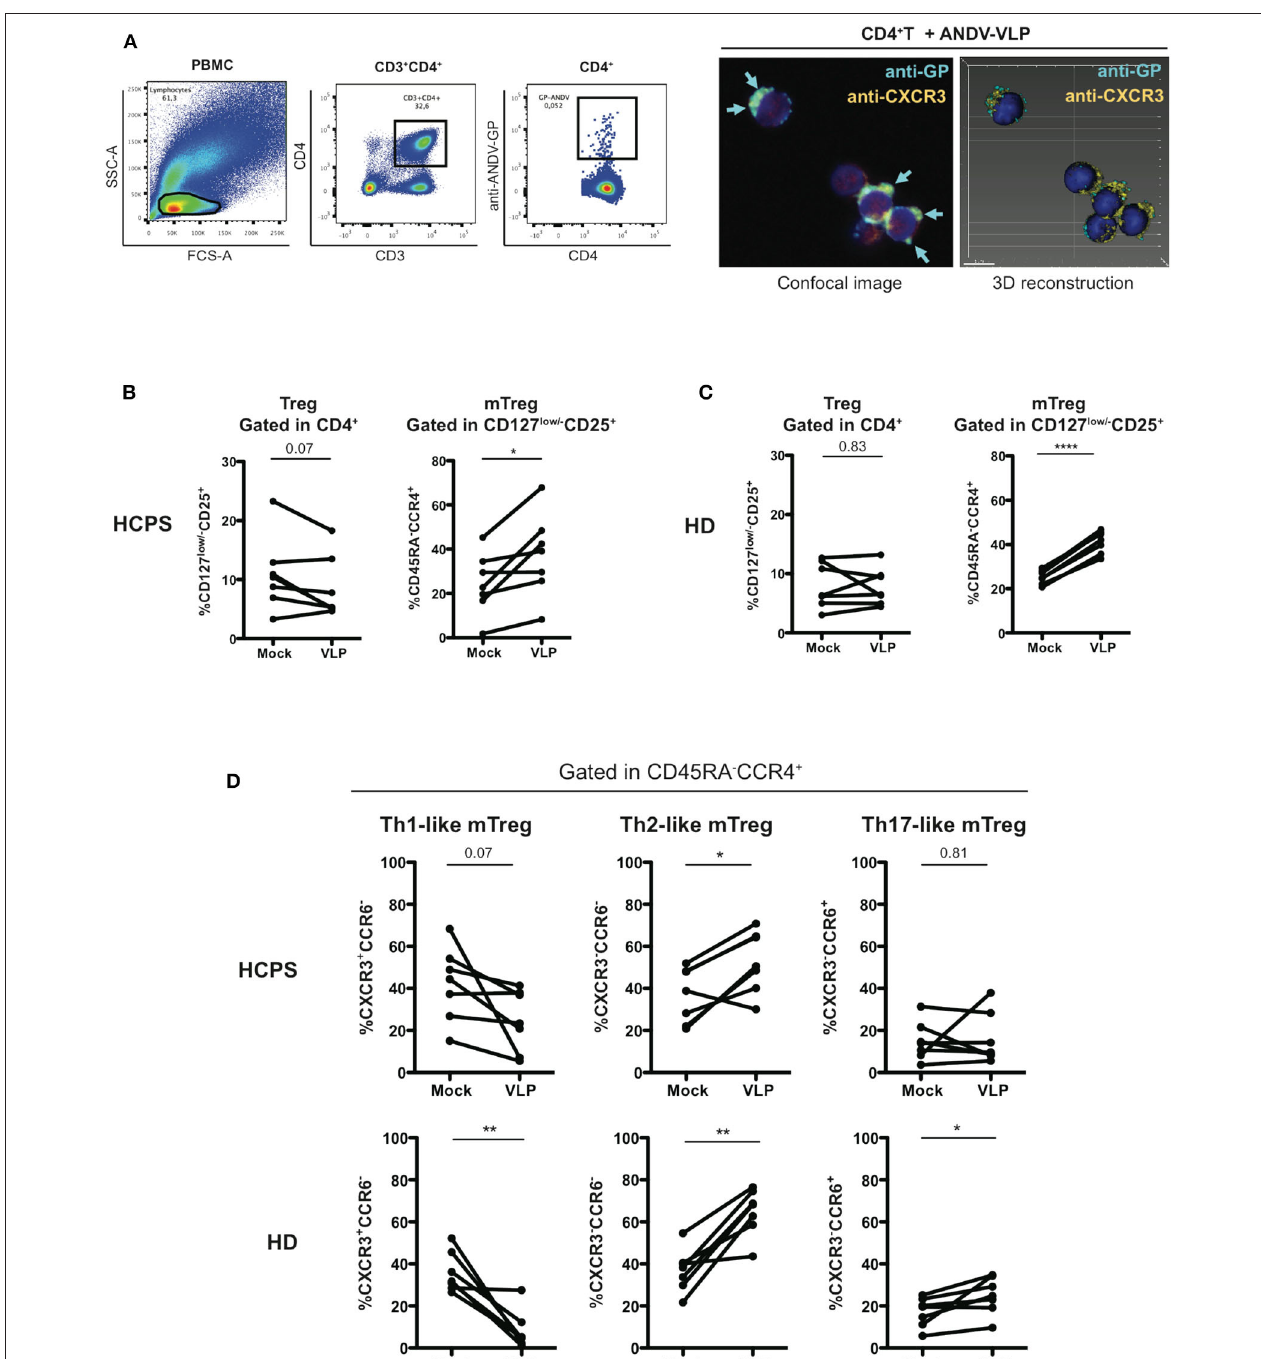
FIGURE 3 | ANDV-GP virus like particles induces a Th2-like phenotype on memory CD4 + Treg cells. (A) ANDV-GP VLPs are detected in CD4 + T cells. PBMC were incubated with VLPs and detected by flow cytometry using an anti-ANDV-GP Qdot655 conjugated antibody (left). Purified CD4 + T cells were incubated with VLP and ANDV-GP was detected with anti-ANDV-GP Qdot655 conjugated antibody and visualized in CD4 + CXCR3 + cells by confocal microscopy, arrows indicate the intracellular ANDV-GP staining (right). Following the same gating strategy of Figure 2 was evaluated the effect of ANDV-GP VLP on Th-like Treg frequency. (B) Frequency of total Treg (CD4 + CD127 low / − CD25 + ) in HCPS and HD PBMCs after VLP overnight stimulation follow by analysis at day 7 of cell culture. (C) Frequency of memory CD4 + Treg CD45RA − CCR4 + in HCPS and HD in mock and VLP stimulus. (D) Frequency of Th-like memory CD4 + Treg CCR4 + in HCPS (above panel) and HD (below panel) in mock and VLP conditions. Data for each individual is represented as a line connecting mock and VLP conditions (HD n = 7; HCPS n = 7), * P < 0.05; ** P < 0.001, **** P < 0.0001 by paired Student’s t -test.